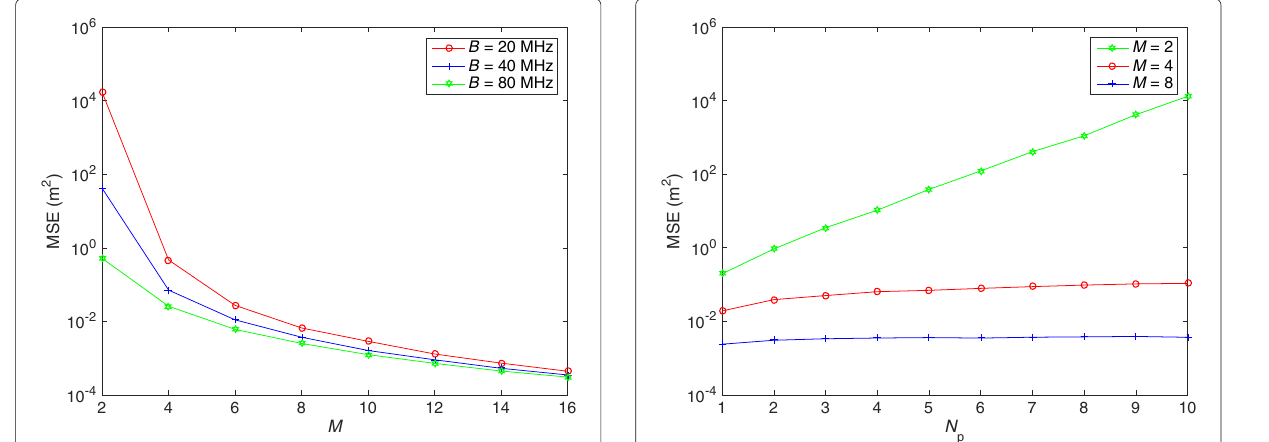
Fig. 5 Numerical result 3. MSE versus N P with M as a parameter, for B = 40 MHz, δ = 10 ns, and ρ = 0